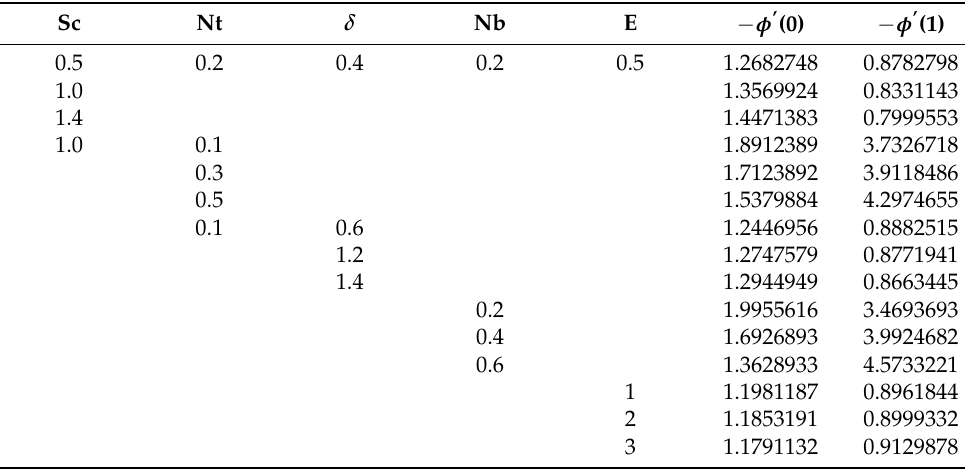
Table 4. Numerical values for mass transfer